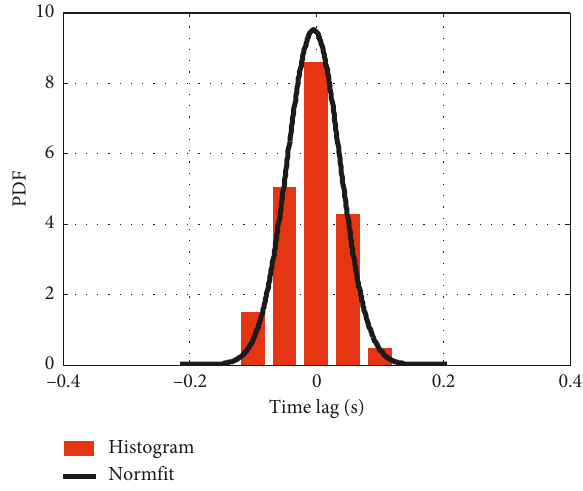
Figure 15: PDF of the time lags identified for the reference configuration at 1.8Hz.